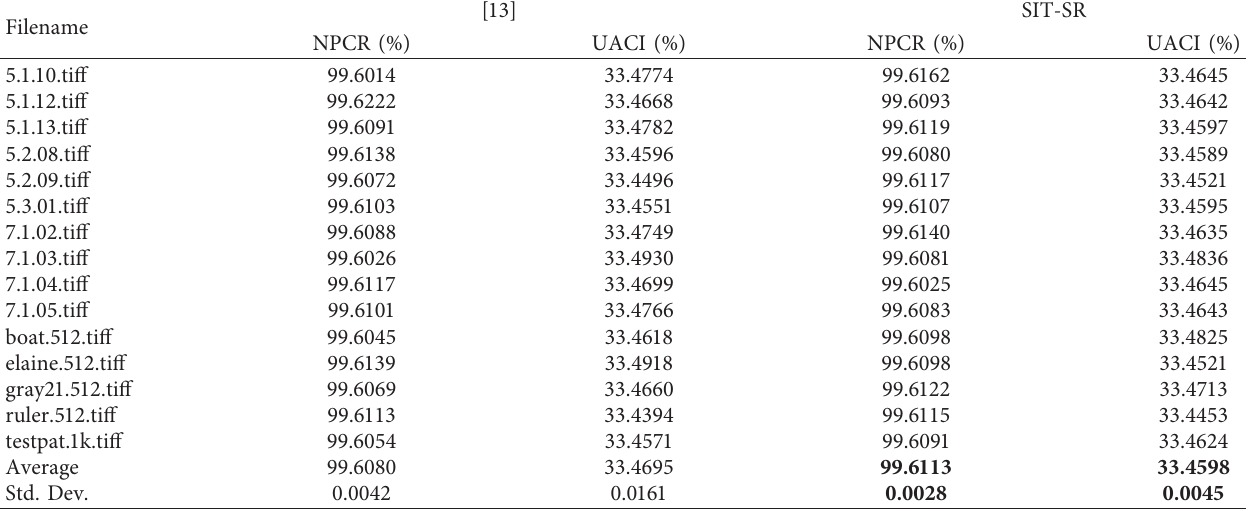
Table 7: NPCR and UACI test results on plain image sensitivity.